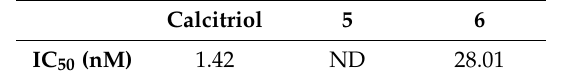
Table 2. Induction of CD14 expression by calcitriol and analogs a .